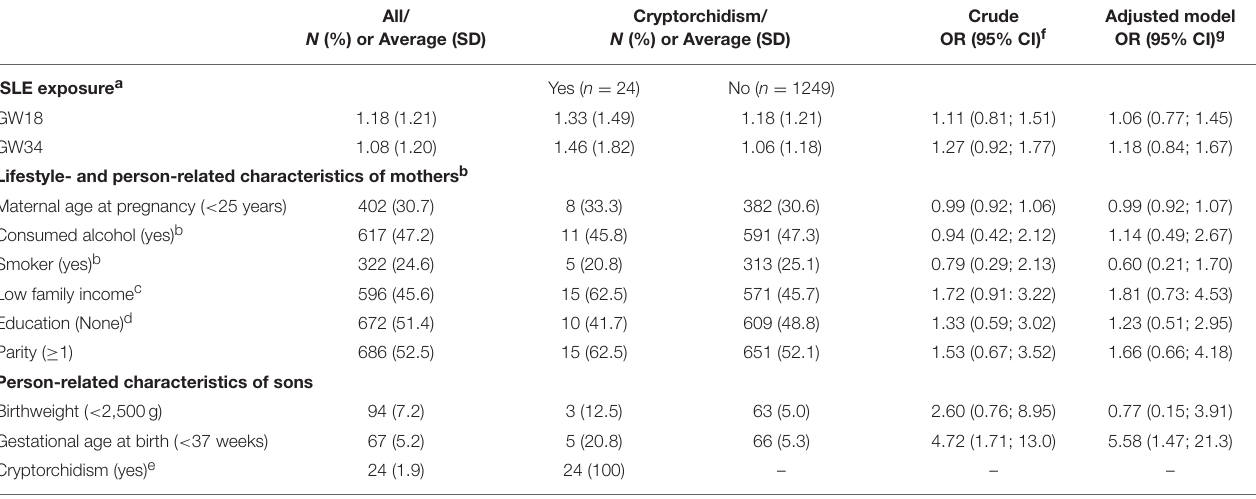
TABLE 2 | Characteristics of the 1,273 sons and association between SLE exposure in early (GW18) and late (GW34) pregnancy and risk of cryptorchidism in sons. All/ N (%) or Average